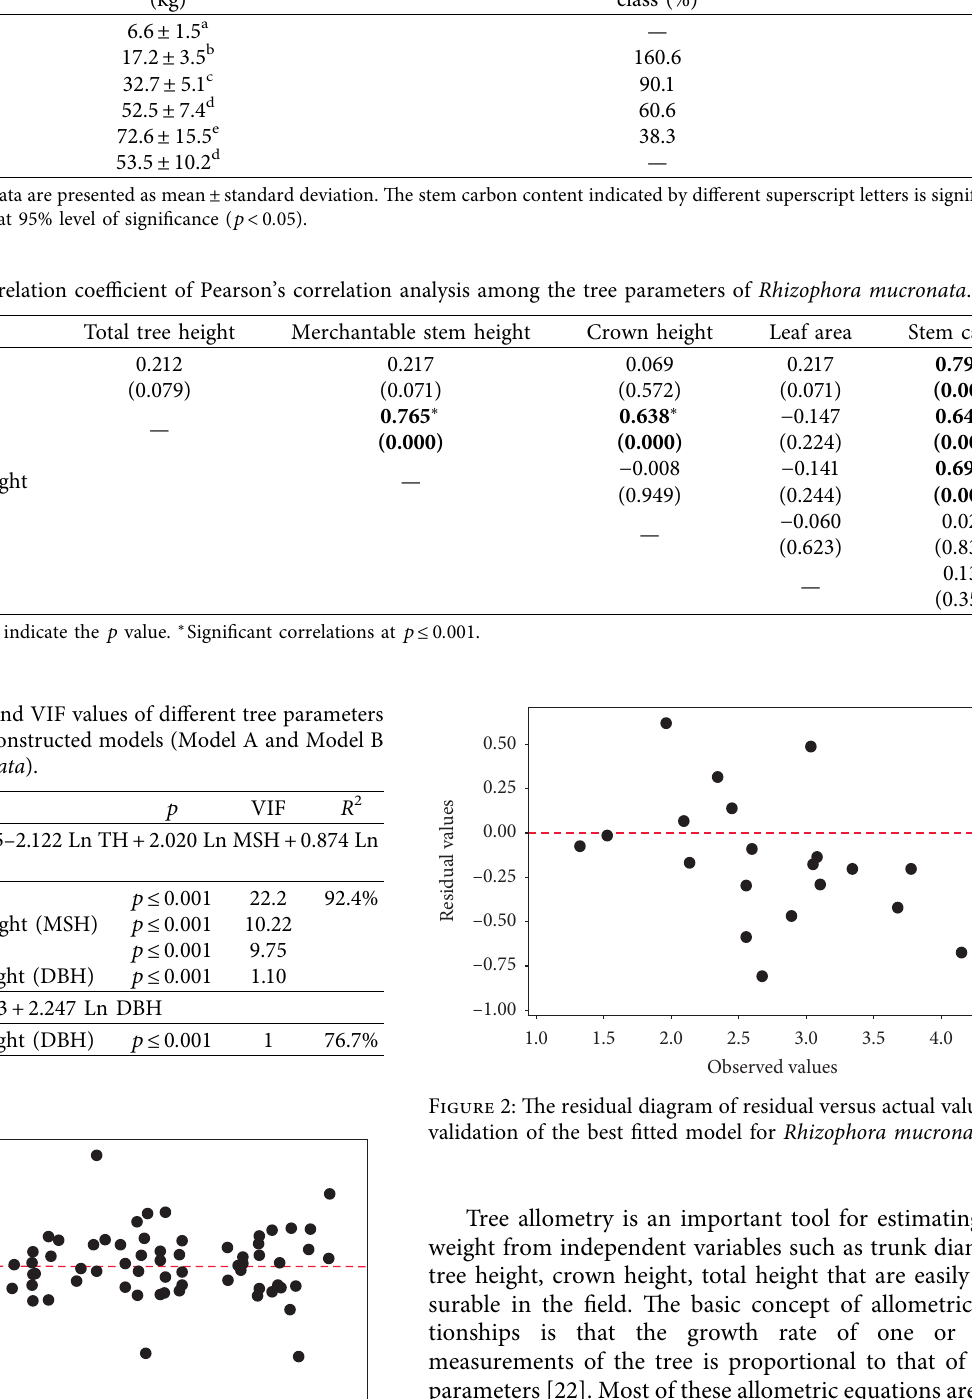
Table 2: The stem carbon content of Rhizophora mucronata at different classes of diameter at breast height. Diameter at breast height